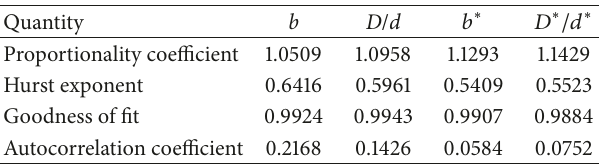
Table 4: The Hurst exponent values of the evolutional hierarchy of Chinese cities